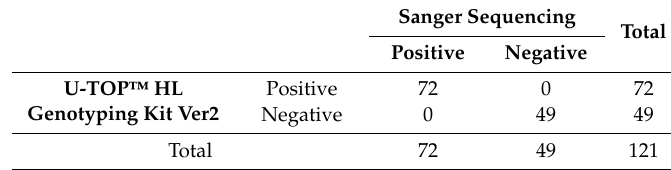
Table 1. Comparison of results between U-TOP ™ HL Genotyping Kit Ver2 and Sanger sequencing. Sanger Sequencing Total Positive Negative U-TOP ™ HL Positive Genotyping Kit Ver2